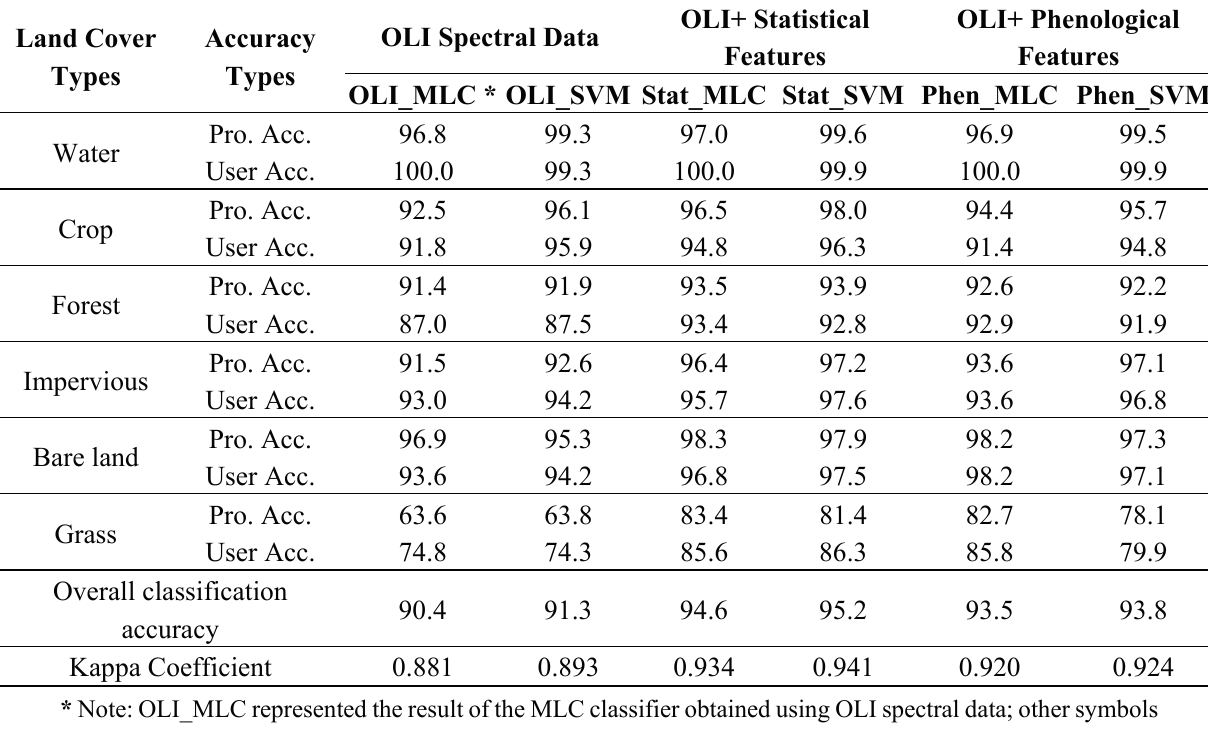
Table 2. Classification accuracies for MLC and SVM classifiers with different configurations